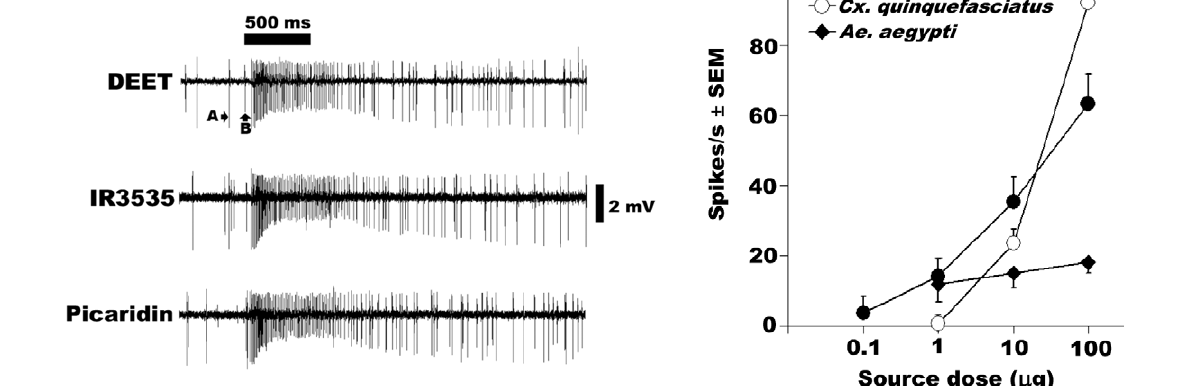
Figure 6. Comparative DEET-elicited responses. DEET-induced excitatory responses from Drosophila pbA1 ORN showed lower threshold than those recorded from the DEET-sensitive mosquito ORNs from the Southern House mosquito, Cx. quinquefasciatus [20] and the yellow fever mosquito, Aedes aegypti [21], respectively. Error bars are standard error of the mean (SEM).